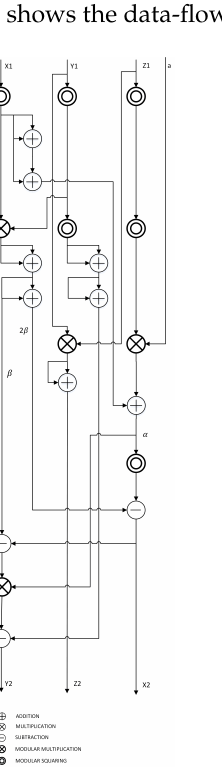
Figure 2. Data Flows (Left to Right) 1. Point-doubling ECPD for SEC2P256K1 curve, 2. Optimized area for point doubling, 3. Point